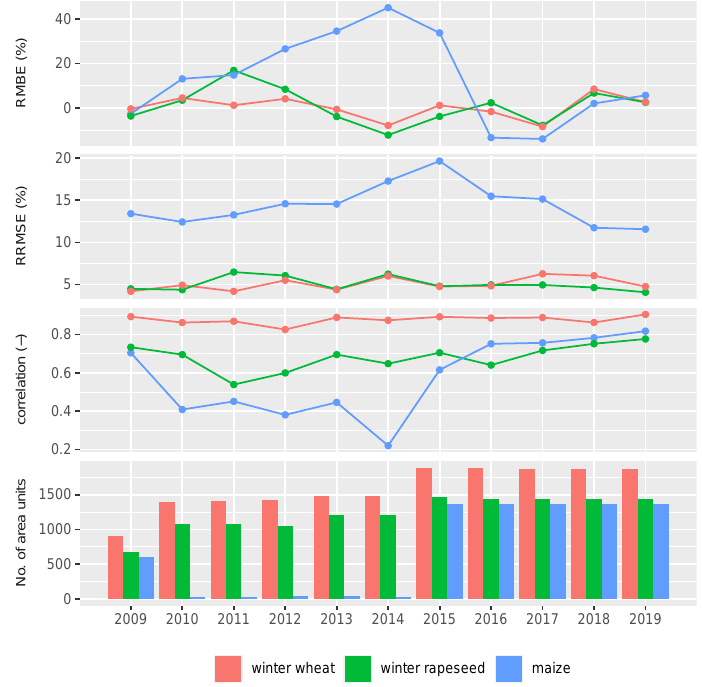
Figure 14. Time series of quality metrics of crop yield predictions for LAU units after the vegeta- tion season.